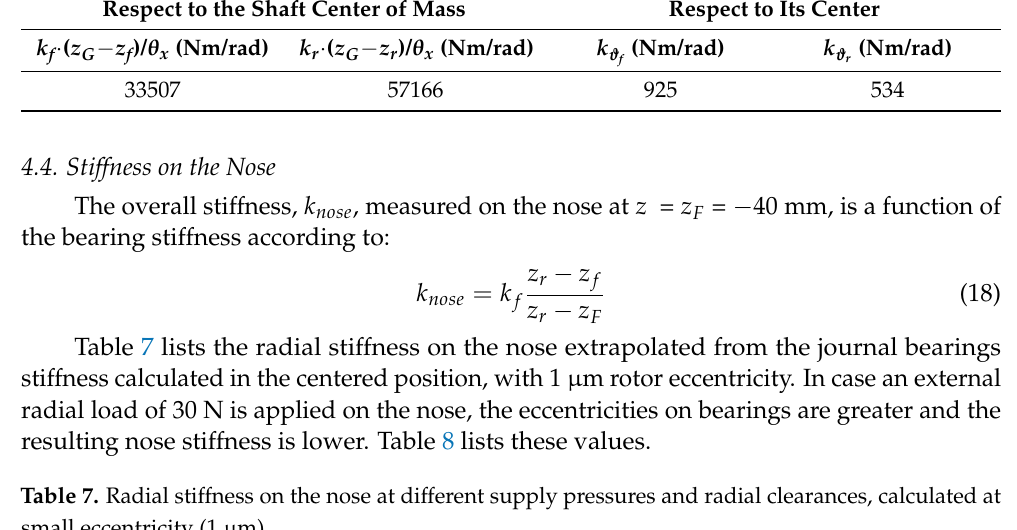
Table 6. Comparison between different contributions to tilting stiffness; results refer to geometrical configuration with h f = 19 µ m, h r = 23 µ m and supply pressure p s = 0.7 MPa. Tilting Stiffness of Journal Bearing with Tilting Stiffness of Journal Bearing Respect to the Shaft Center of Mass Respect to Its Center